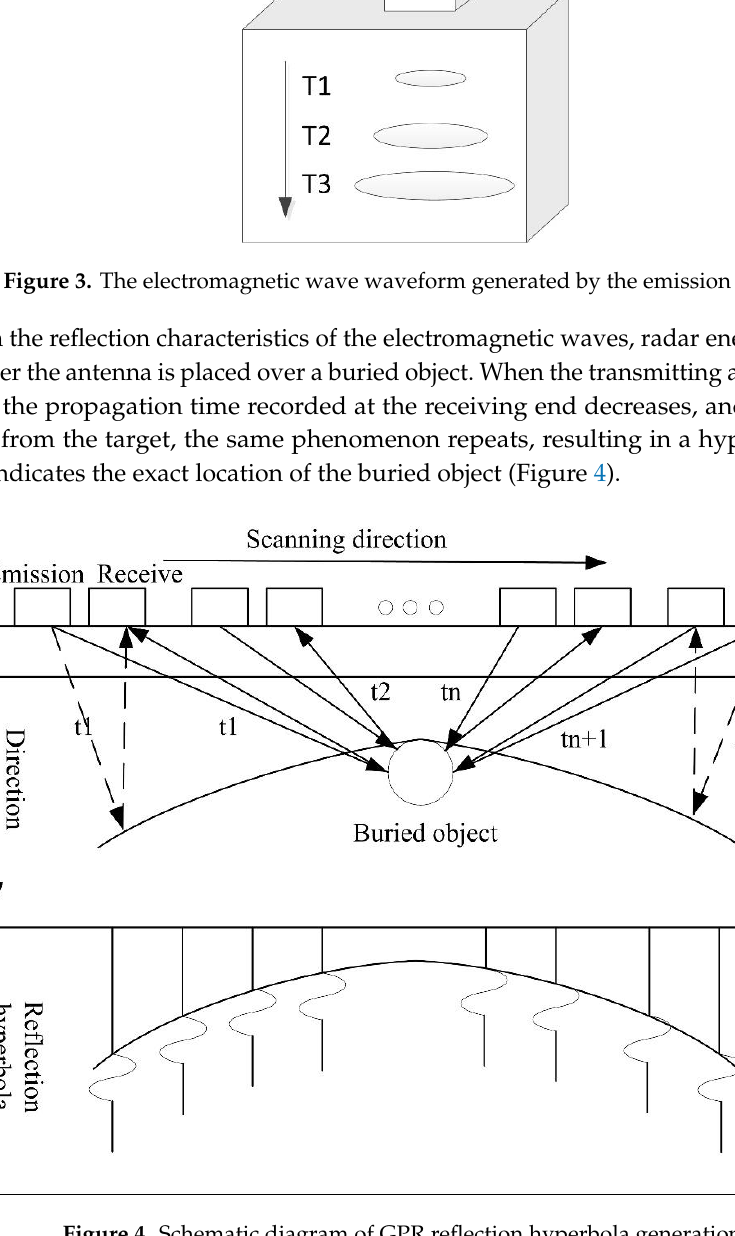
Figure 3. The electromagnetic wave waveform generated by the emission source.